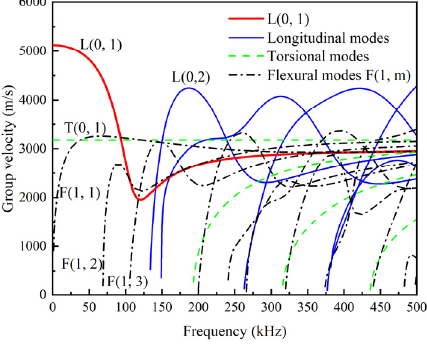
Figure 2. Dispersion curves of a typical infinitely long cylindrical rod with diameter of 27 mm.